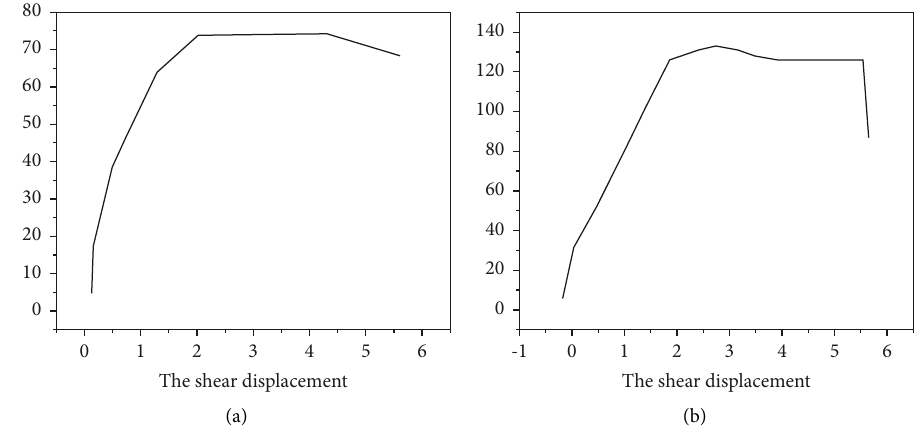
Figure 3: Stress-strain relationship curves under different vertical